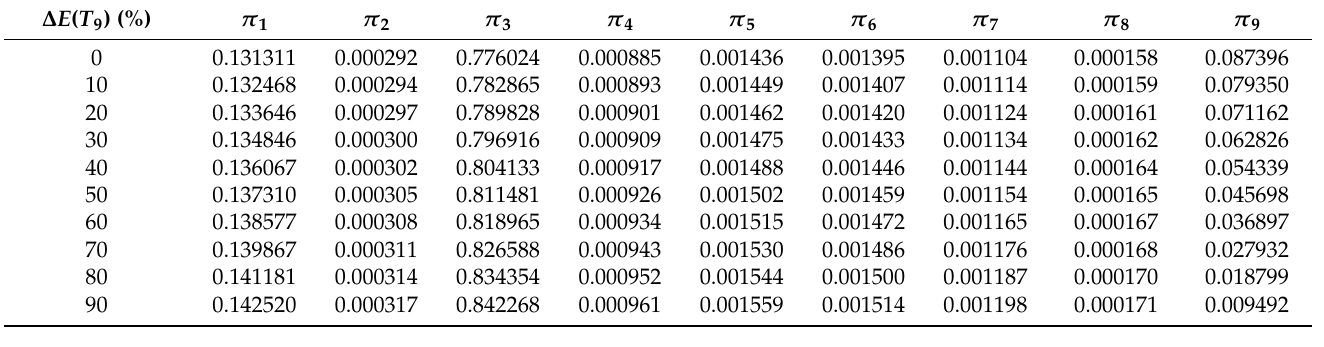
Table 8. Ergodic probabilities obtained in sensitivity analysis of SMM.